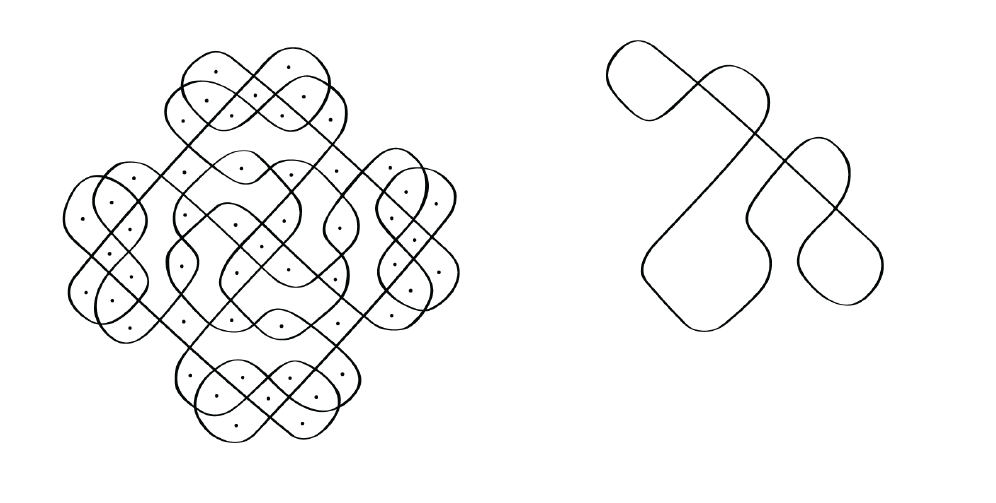
Matthew Allen, Kolam Threshold Design: The Pattern as Topological Snare and The Constitutive Element of the Kolam, after a diagram in Alfred Gell, Art and Agency (Oxford: Clarendon, 1998), 85 and 86 (photo: